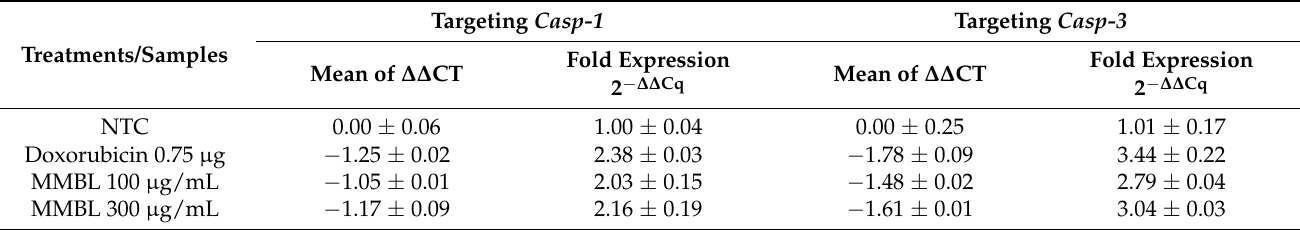
Figure 3. Comparison of change in the expression of Casp-1, -3, -7 , and -9 genes expressed as target gene/GAPDH in MCF-7 cells after 24 h exposure with MMBL. NTC: non-treated cells; Doxo: Doxorubicin; a positive control, MMBL: methanolic extract of M. buxifolia leaves. ( A ) p < 0.0002 = *** treated cells vs. non-treated cells. ( B ) p < 0.001 = *** treated cells vs. non-treated cells. ( C ) p < 0.001 = *** treated cells vs. non-treated cells. ( D ) p < 0.001 = *** treated cells vs. non-treated cells. ( E ) p < 0.0092 = ** treated cells vs. non-treated cells. ( F ) p < 0.0002 = *** treated cells vs. non-treated cells. All the experiments were repeated twice with triplicate. Where * denotes p < 0.05 in treated cells vs. non-treated cells. Table 3. Summary of Casp-1 and Casp-3 -fold expression by real-time PCR for MMBL ( n = 6).